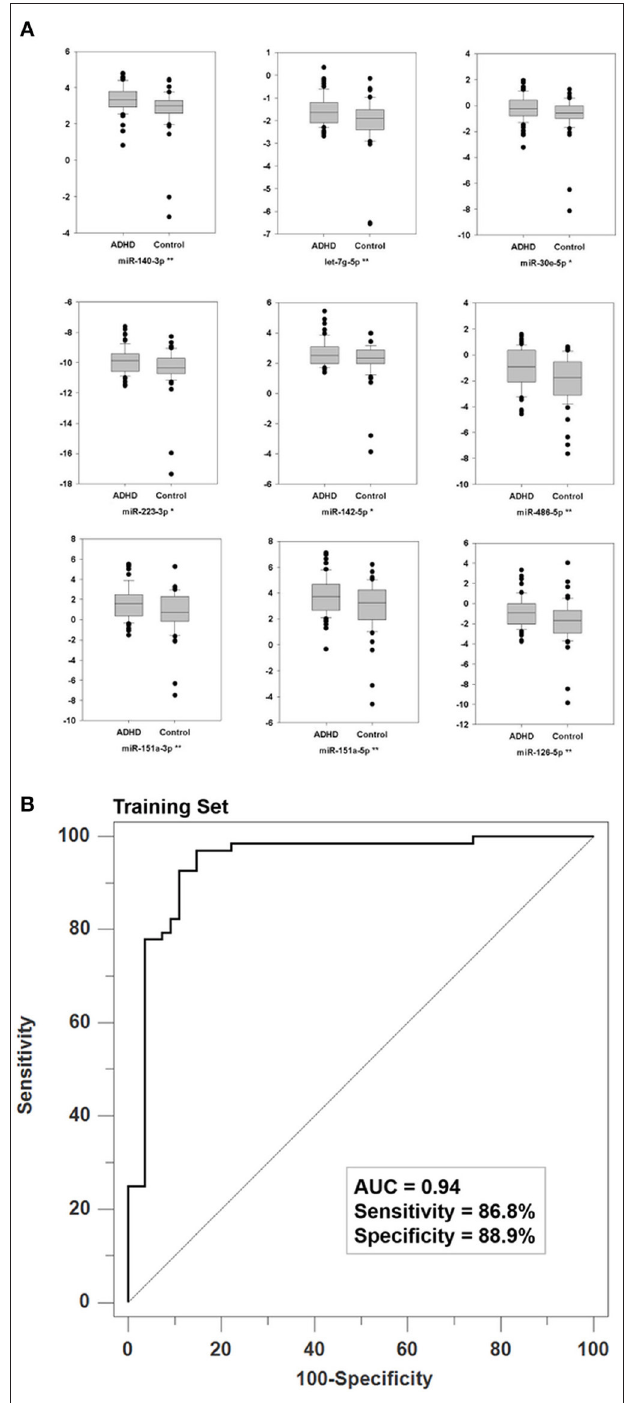
FIGURE 2 | Specific validation of biomarker miRNAs and their discrimination power. (A) We used qPCR to validate the expression profiles through NGS in all RNA samples from the Training Set. The Y-axis denotes the 1 Ct values with U44 as the internal control. For each miRNA, * and ** denote P < 0.05 and P < 0.01, respectively. (B) Using the 1 Ct values of 13 biomarker miRNAs as vectors (predictors), the Support Vector Machine (SVM) achieved a classification model with an AUC value of 0.94 where the two parameters of gamma and cost were 0.015625 and 256, respectively.